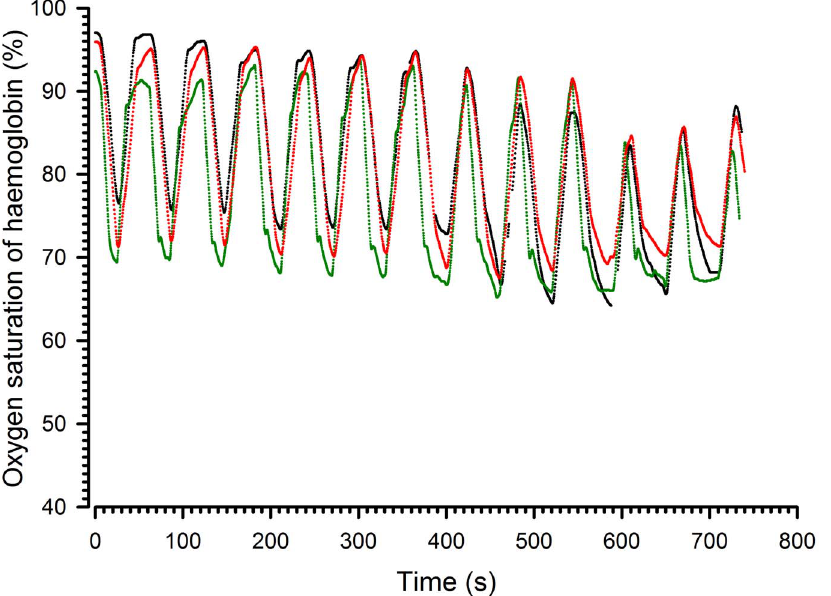
Figure 6. Representative records of haemoglobin oxygen saturation at different positions in the chamber. The black line corresponds to box 1, the green line to box 3 and the red line to box 5. FIO 2 : 12% alternating with 21% every 30 s.